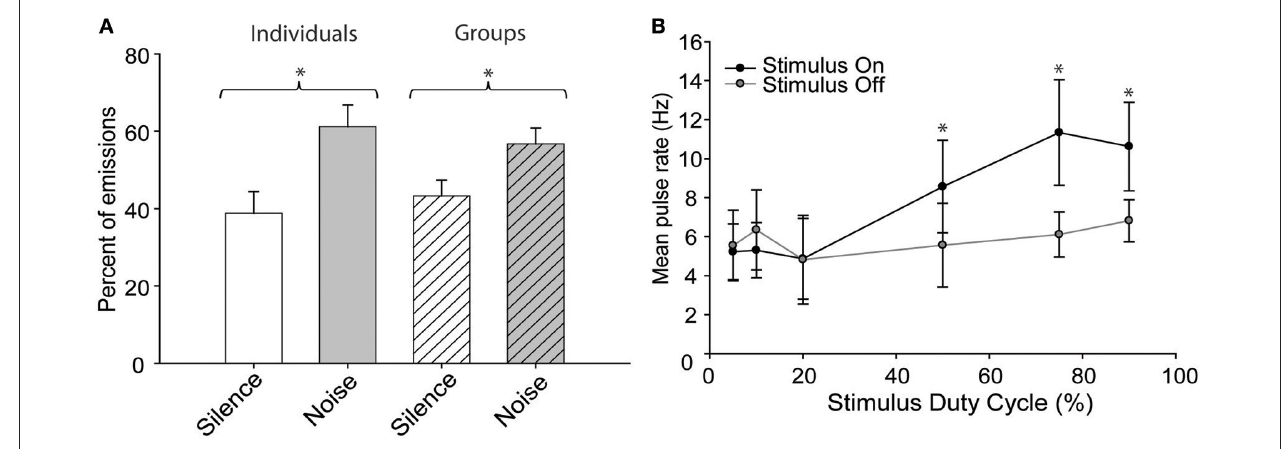
FIGURE 2 | The effect of continuous noise stimuli on pulse emission rates. (A) Bats emitted pulses more frequently in the presence of continuous background noise than during intervening silent periods. The effect was similar whether recording from individuals or groups of bats.